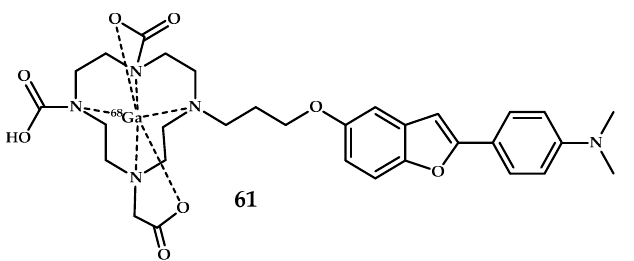
Figure 14. DOTA-benzofuran-based Gd 3 + coordination compound 61 designed for MRI visualization Figure 14. DOTA–benzofuran–based Gd 3+ coordination compound 61 designed for MRI visualization of A β of A β plagues.